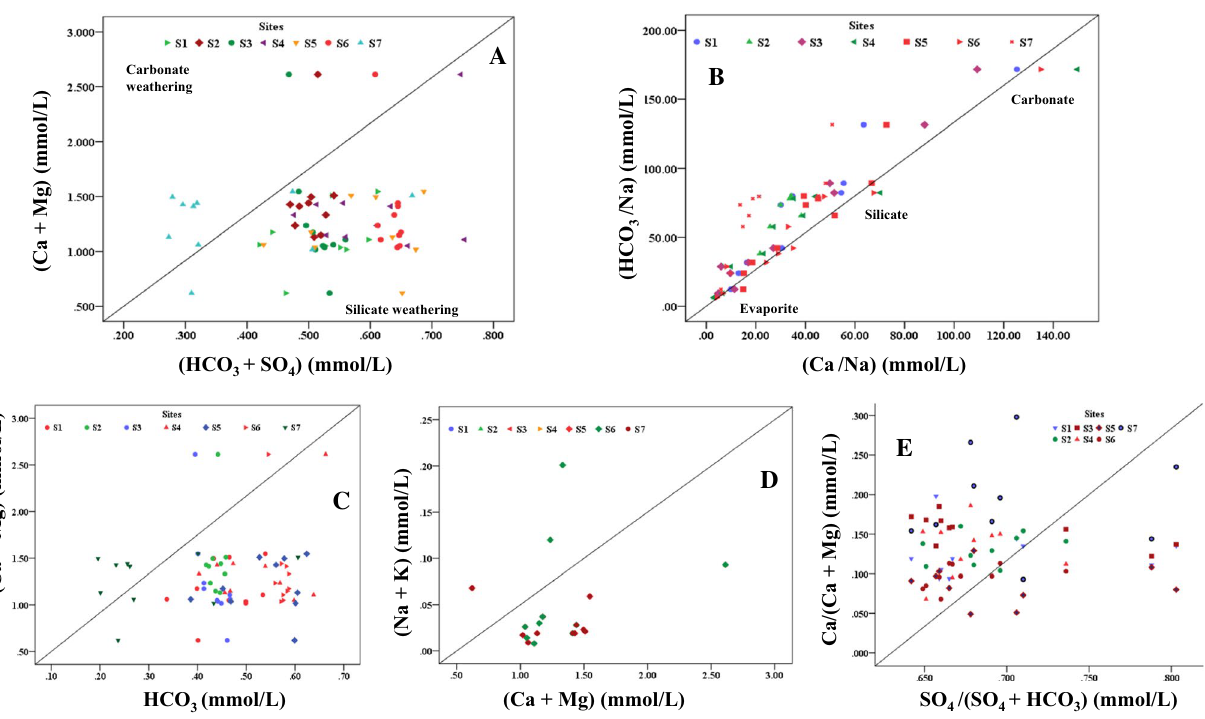
Fig. 7 A – E Scatter plots to identify the most responsible geochemical process for evolution of different water types at high altitude (Leh, Ladakh, India) (Jeelani et al., 2011; Bhat et al., 2019,